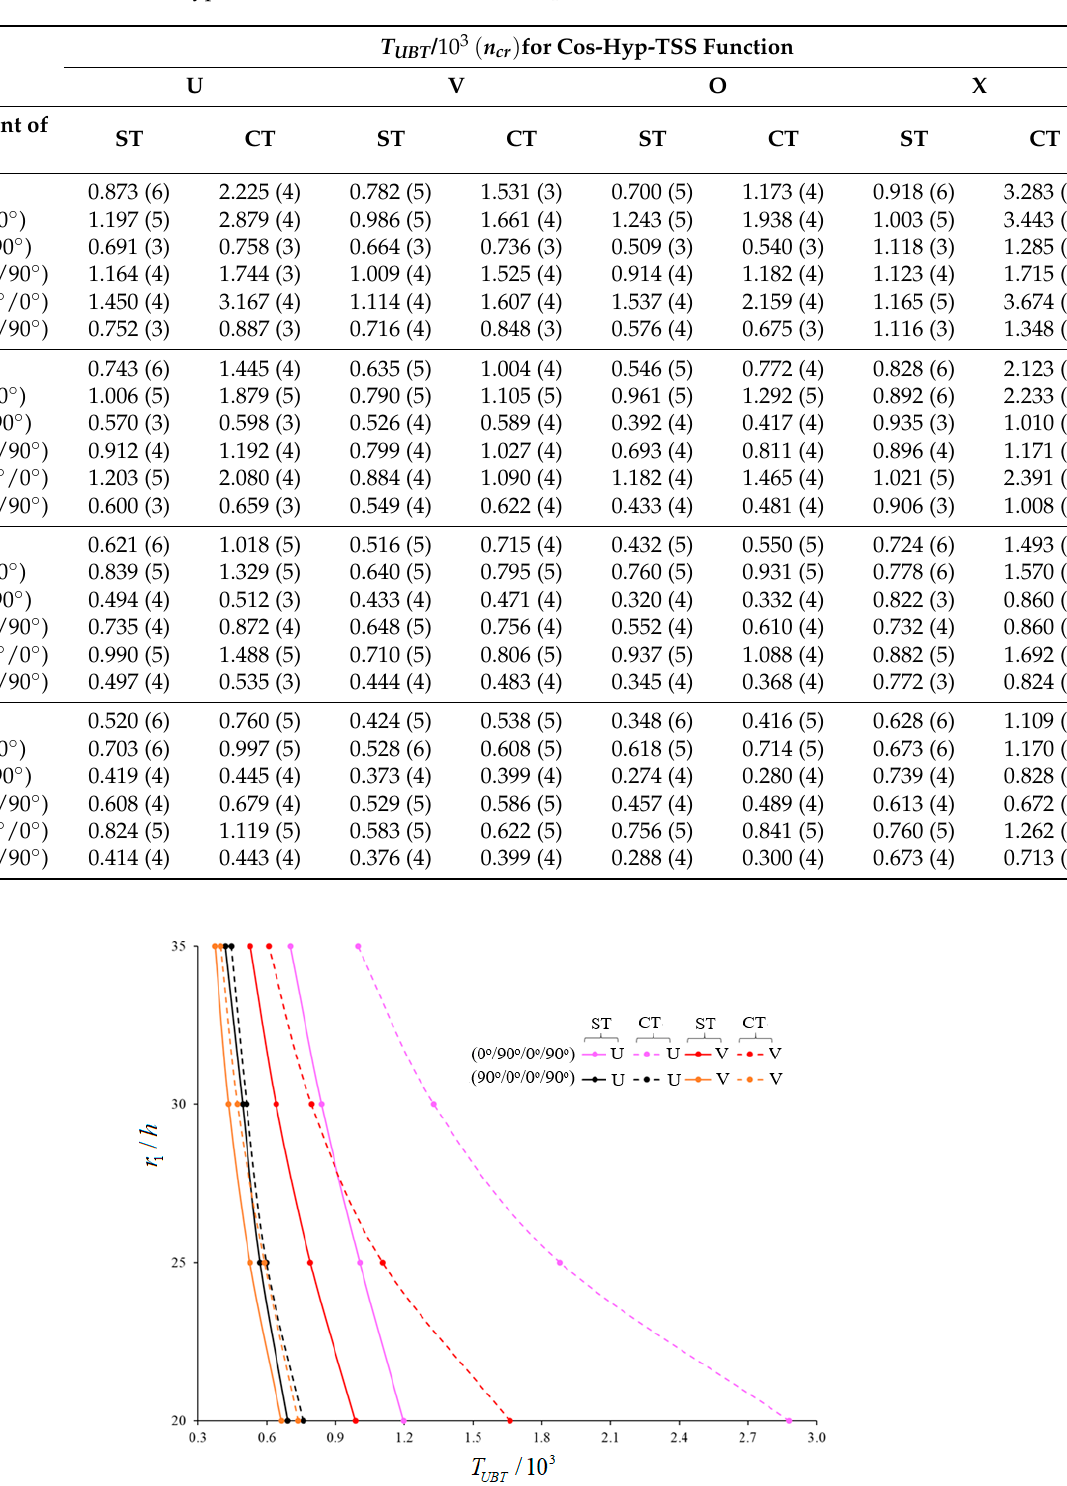
Figure 5. Variations of UBT for (0 ◦ /90 ◦ /0 ◦ /90 ◦ )- and (90 ◦ /0 ◦ /0 ◦ /90 ◦ )-array laminated cones with U- and V-shaped layers for Cos-Hyp-TSS function (within CT versus r 1 / h ).